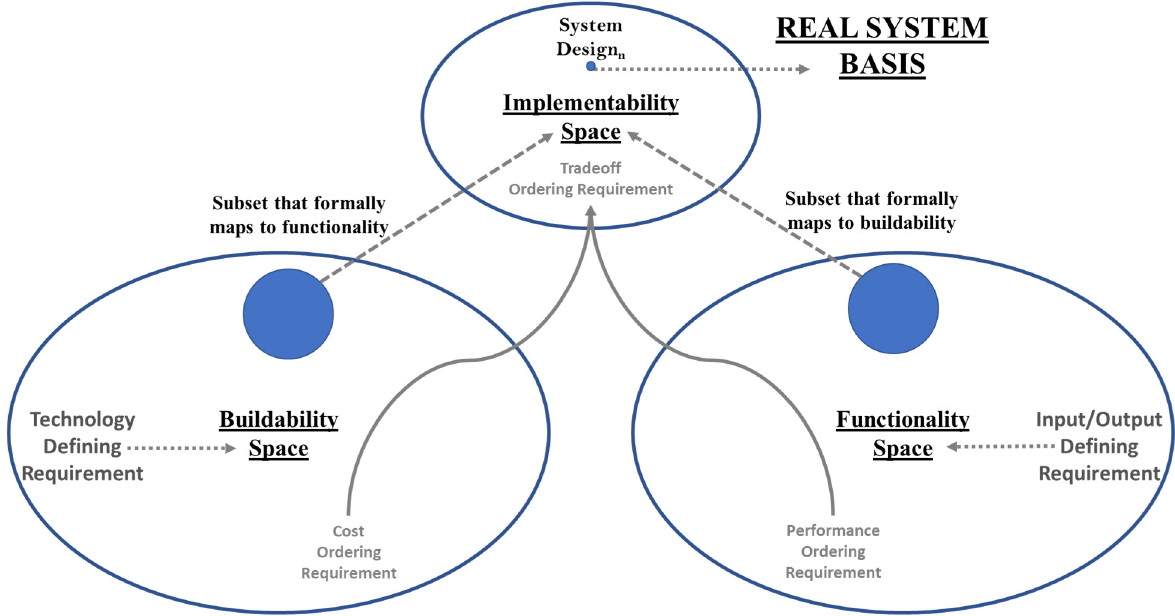
Figure 1. The conceptualization of Wymore’s T3SD (i.e., mathematical theory of MBSE). The functionality space is defined by required input/output and ordered according to preferred performance. The buildability space is defined by required technology and ordered according to preferred cost. The implementability space is defined by the formal mapping between buildability and functionality subsets and ordered according to preferred tradeoff between performance and cost; from which the design for the real system is selected.